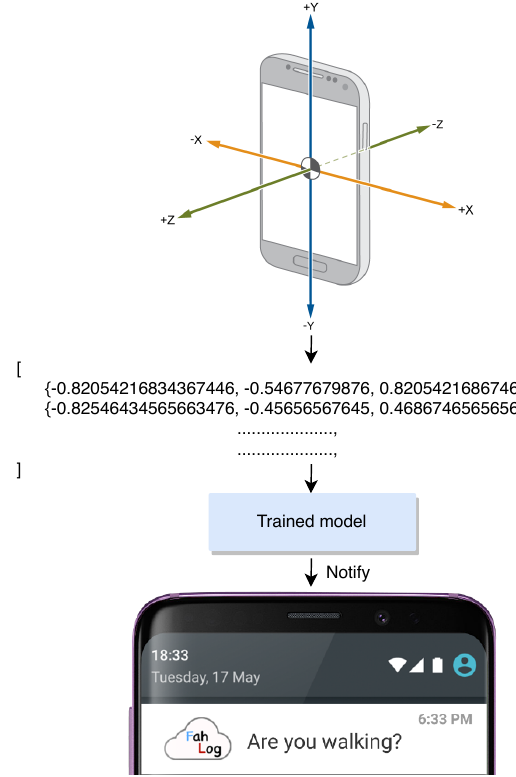
Figure 7. Steps to show a estimated activity as feedback to a